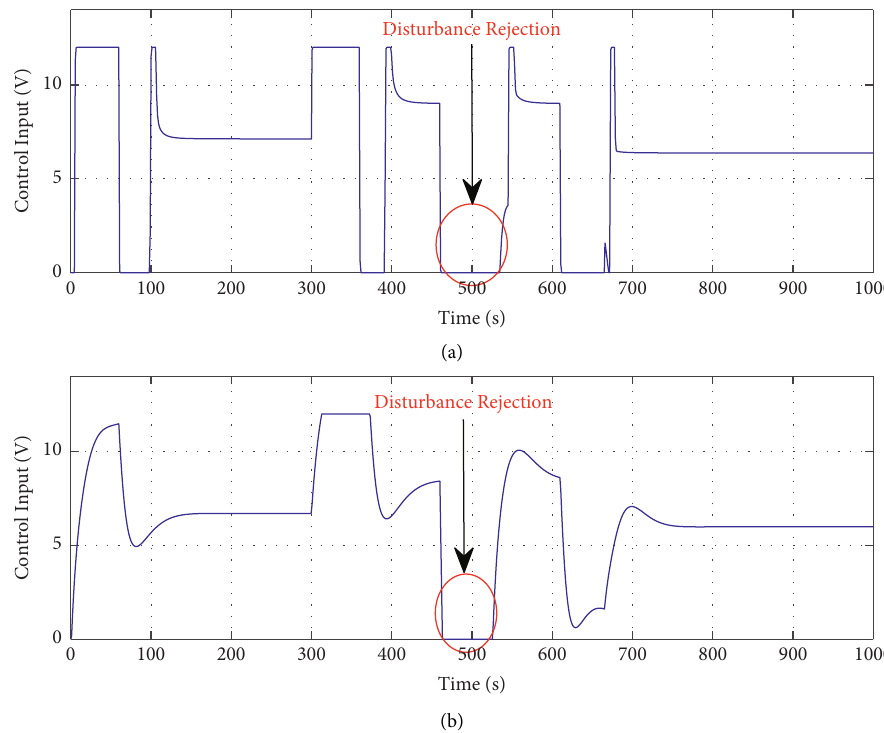
Figure 5: NTSMC and BC signals with external disturbance rejection. (a) NTSM voltage; (b) backstepping voltage.